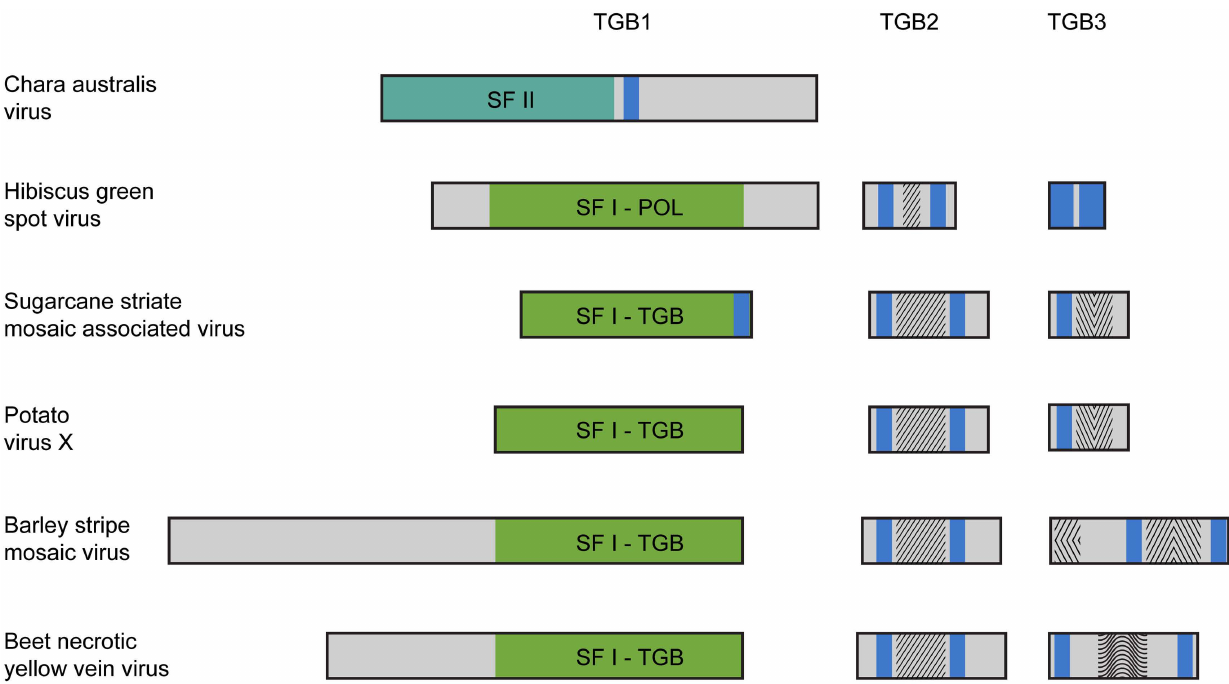
virus X and Sugarcane striate mosaic virus TGB3 proteins, a common signature is located downstream of their single transmembrane domain. This signature is characteristic for the TGB3 proteins in viruses of genera Potexvirus , Allexivirus , Mandarivirus , Carlavirus , and Foveavirus . In the Barley stripe mosaic virus , TGB3 has two unique signatures typical for viruses of the genera Hordeivirus and Pomovirus located in the N-terminal and central hydrophilic sequence segments. In the Beet necrotic yellow vein virus (BNYVV) TGB3, two transmembrane domains are located close to the protein termini, and there is a conserved signature characteristic of the genus Benyvirus only, which is located in the central protein part. The Hibiscus green spot virus TGB3 protein contains extremely short central